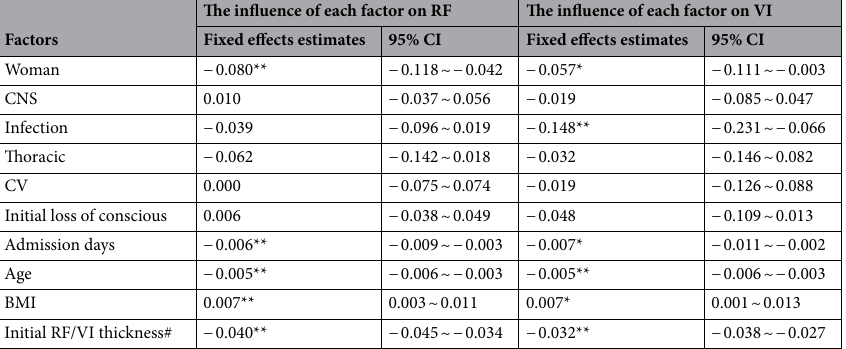
Table 2. The influence of each factor on RF/VI thickness using a linear mixed model. * P value < 0.05, ** P value < 0.001. # : “Initial RF thickness” used as a factor in RF analysis and “Initial VI thickness” used in VI